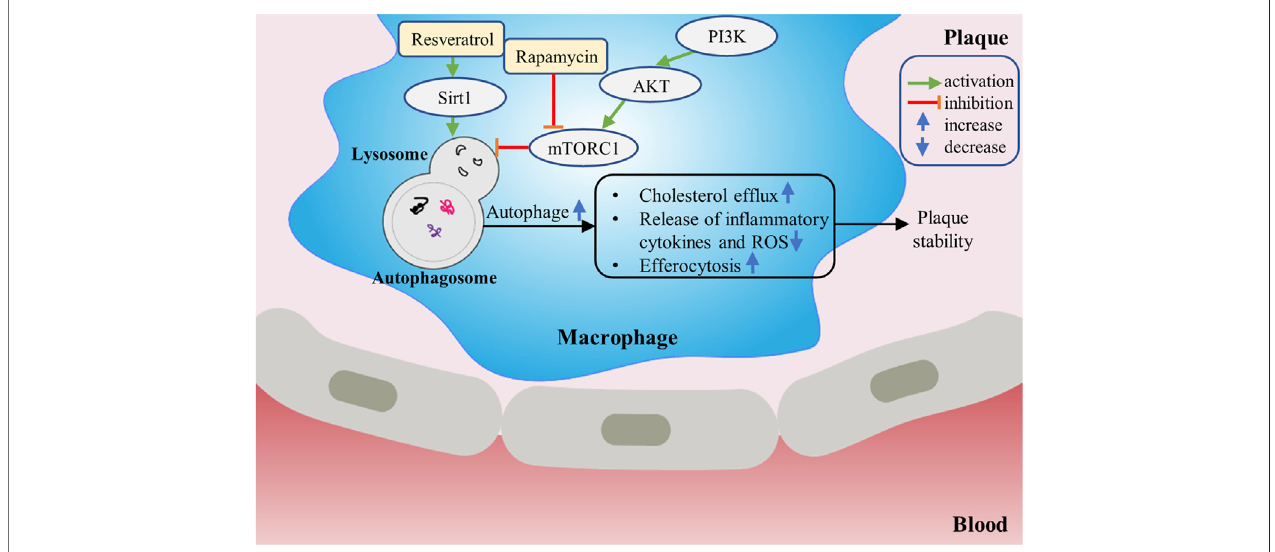
FIGURE 2 | The protective role of macrophage autophagy in atherosclerosis. Drugs such as rapamycin can increase autophagy of macrophages by inhibiting mTORC1.Up-regulationofmacrophage autophagycanincrease cholesterolef fl ux, promote efferocytosis, inhibitin fl ammatoryresponse and suppress oxidativestress, thereby contributing to stabilizing the